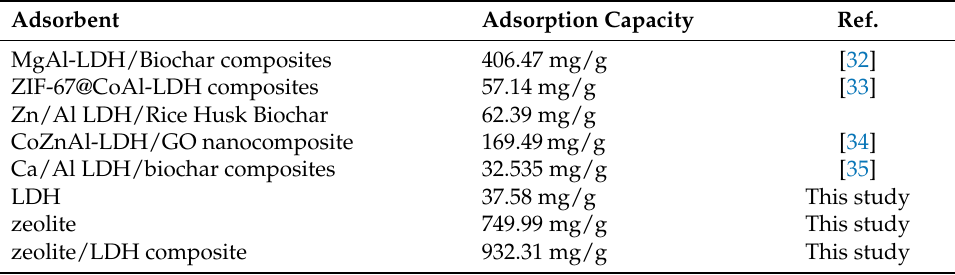
Table 1. Comparison of adsorption capacity ( q m ) for different adsorbents for removing of MB.